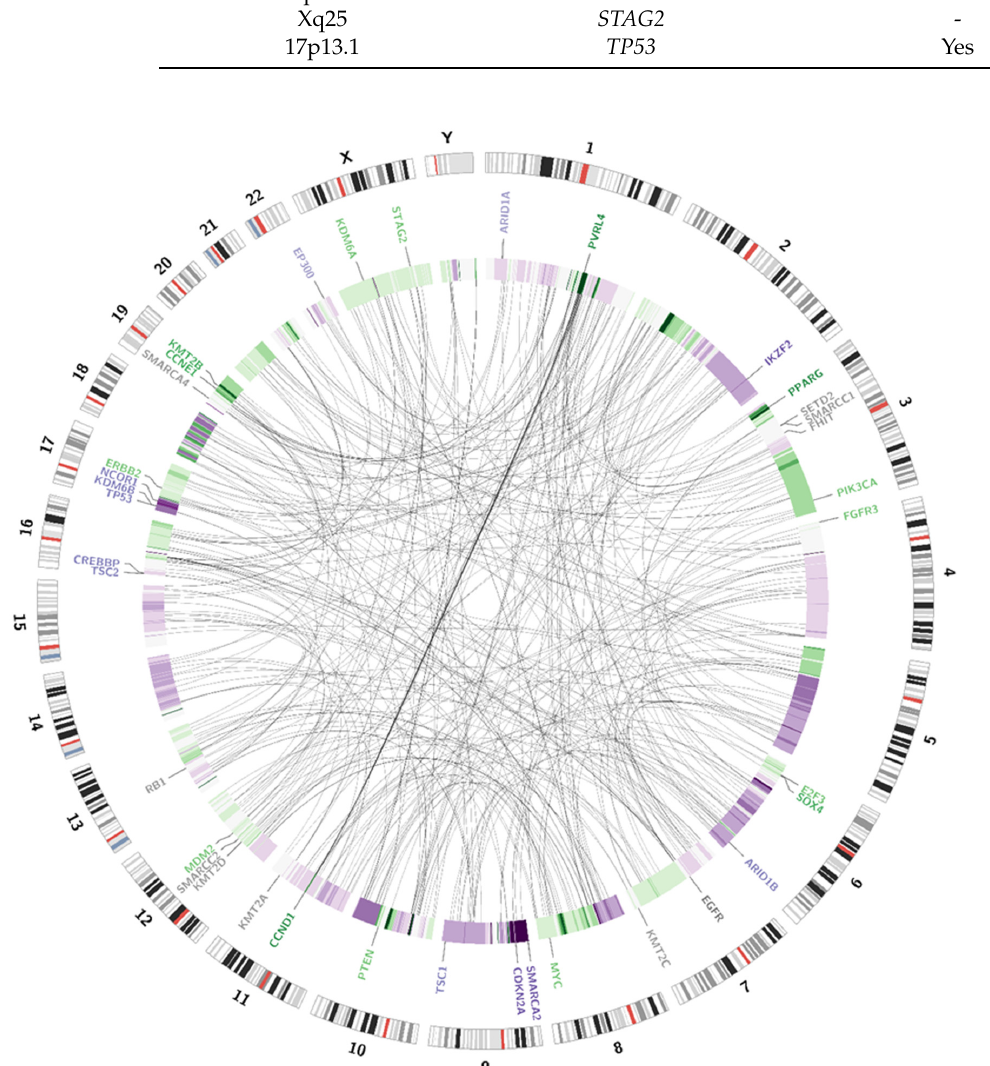
Figure 3. Visualisation of structural variations. The external circle represents an ideogram, while the internal circle illustrates the coverage difference between the patient’s blood samples and urine samples. The darker the green area, the larger are the amplification rates. The darker the purple colour, the larger is the deletion. Genes are coloured according to the copy number alternations of their loci: purple—deletions; green—amplifications; grey—no change in copy number. The link inside the graph visualises the pattern of corresponding sequences.